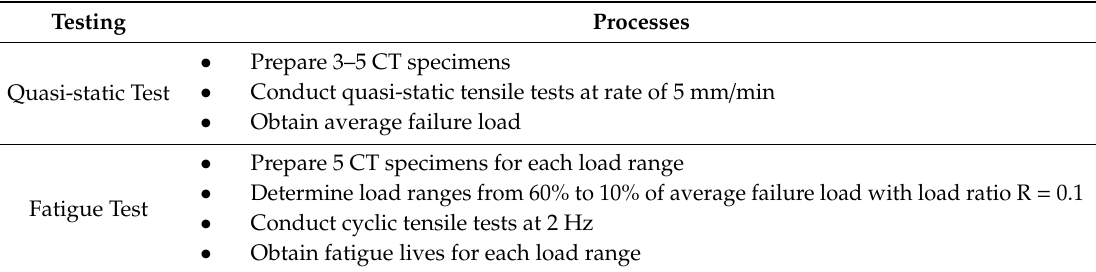
Table 3. A testing protocol of the quasi-static and fatigue tests.